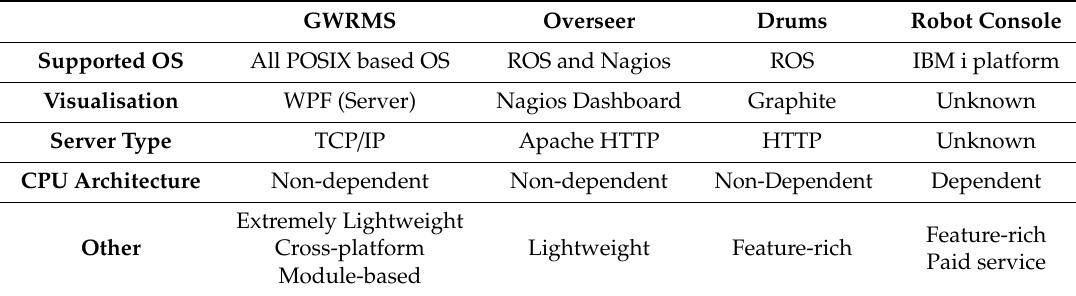
Table 1. Comparison between previous systems and the